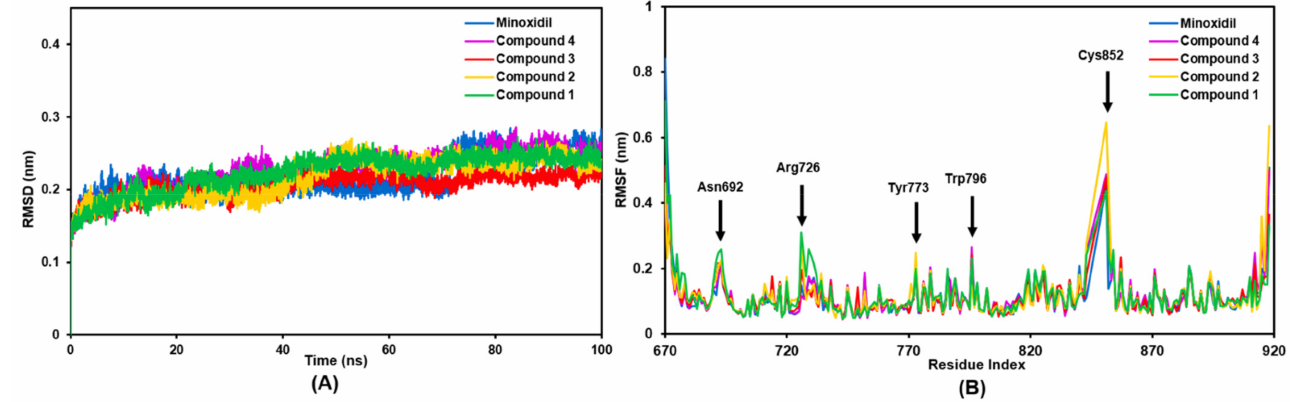
Figure 2. The plots of ( A ) RMSD of backbone atoms for AR-compound complex, and ( B ) RMSF of backbone atoms for AR-compound complex during 100 ns of